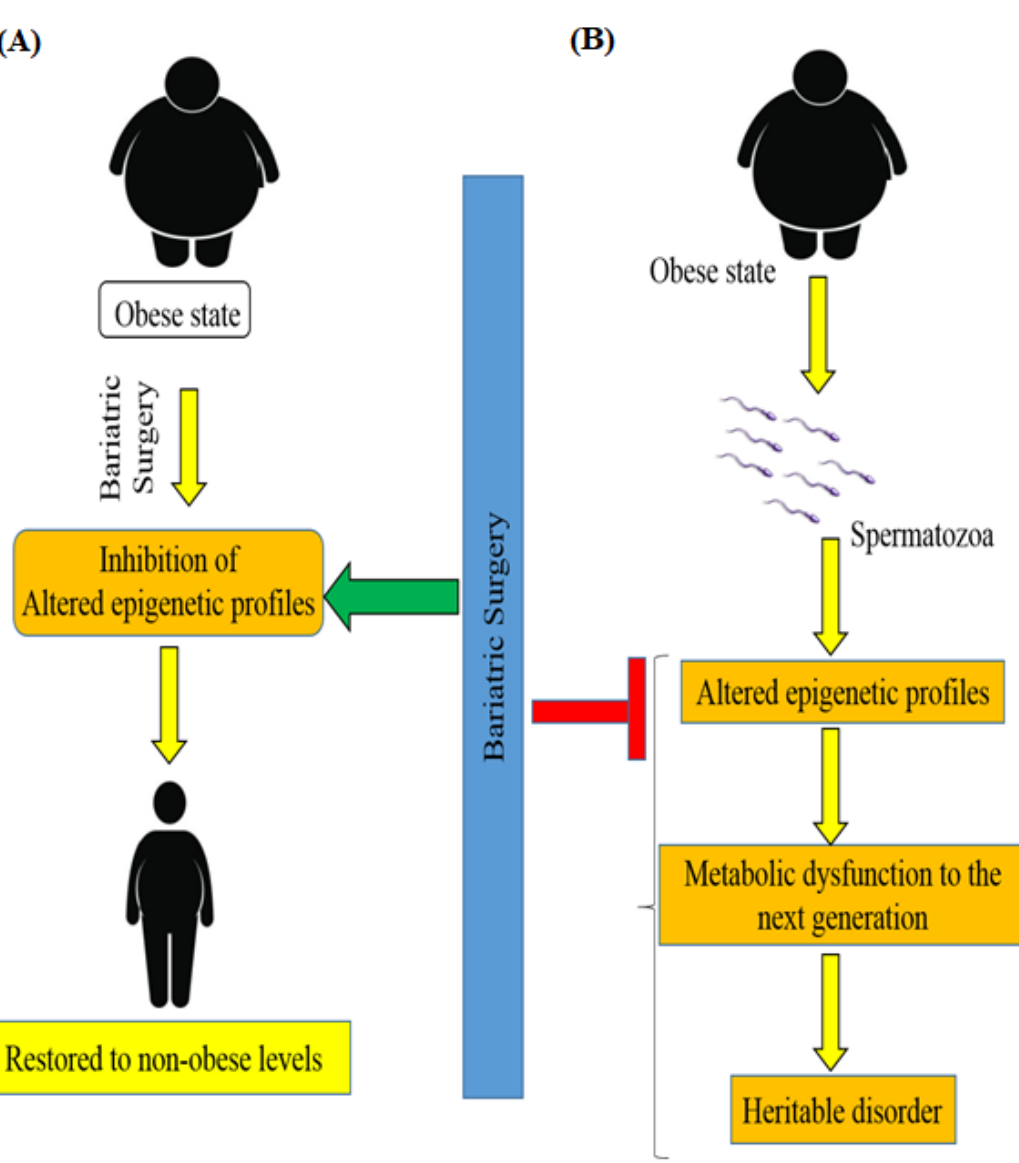
Figure 4. Schematic diagram showing the impact of bariatric Surgery on the epigenetics of patients with obesity and T2DM. ( A ) Bariatric surgery significantly inhibits the alteration of DNA methylation and restores the altered epigenetic profiles to non-obese levels in patients with metabolic disorders. ( B ) Additionally, surgery-induced weight loss inhibits the heritability of the disorder by the next generation by altering the epigenetic profiles.